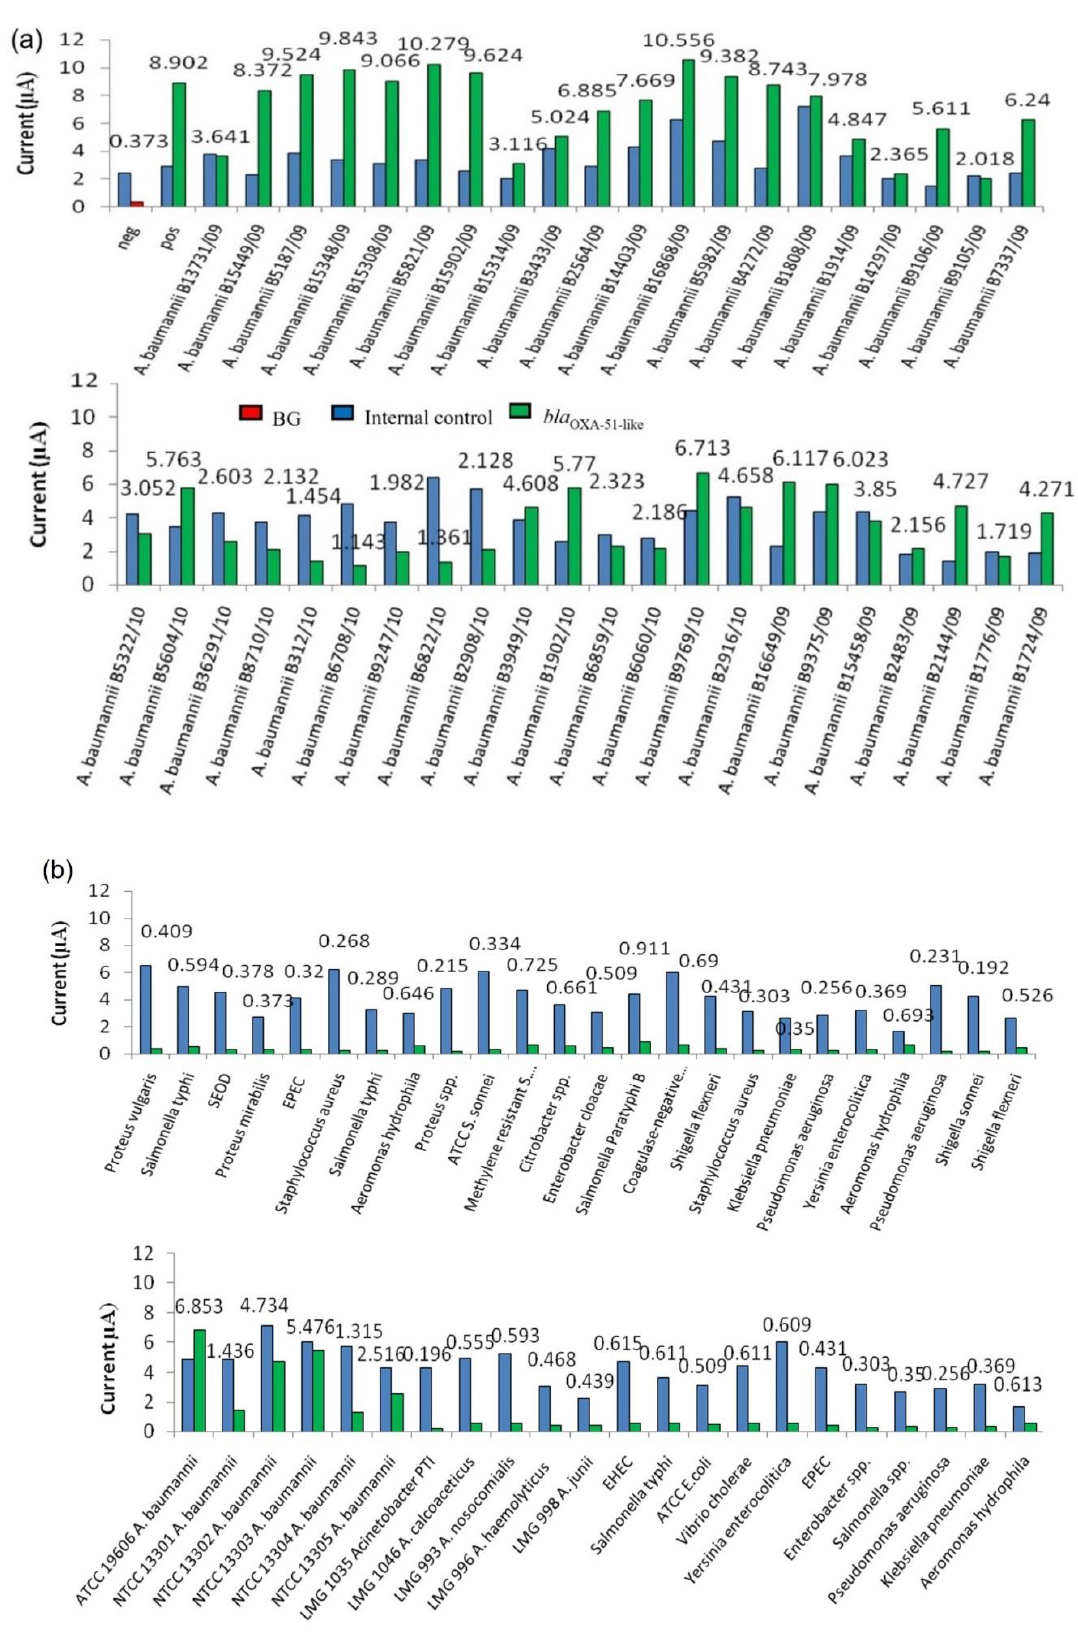
Figure 5. ( a ) Diagnostic evaluation of the enzyme-based electrochemical DNA biosensor using different A. baumannii clinical strains. ( b ) Diagnostic evaluation of the enzyme-based electrochemical DNA biosensor using different A. baumannii reference strains and other non- Acinetobacter